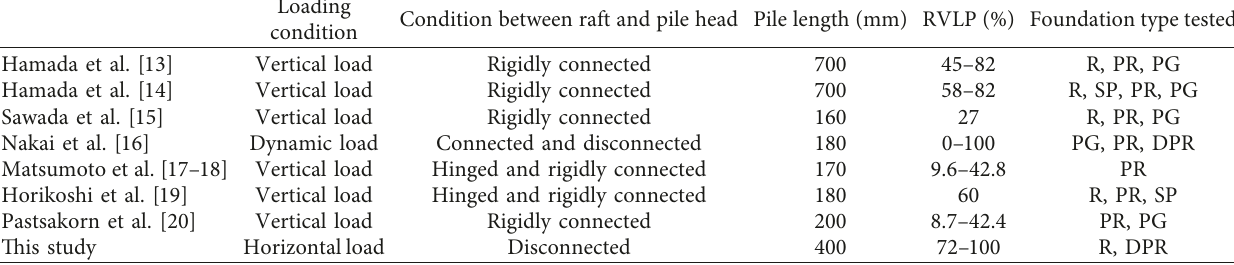
Table 1: Summary of previous studies on piled raft foundations subjected to a static horizontal load and this